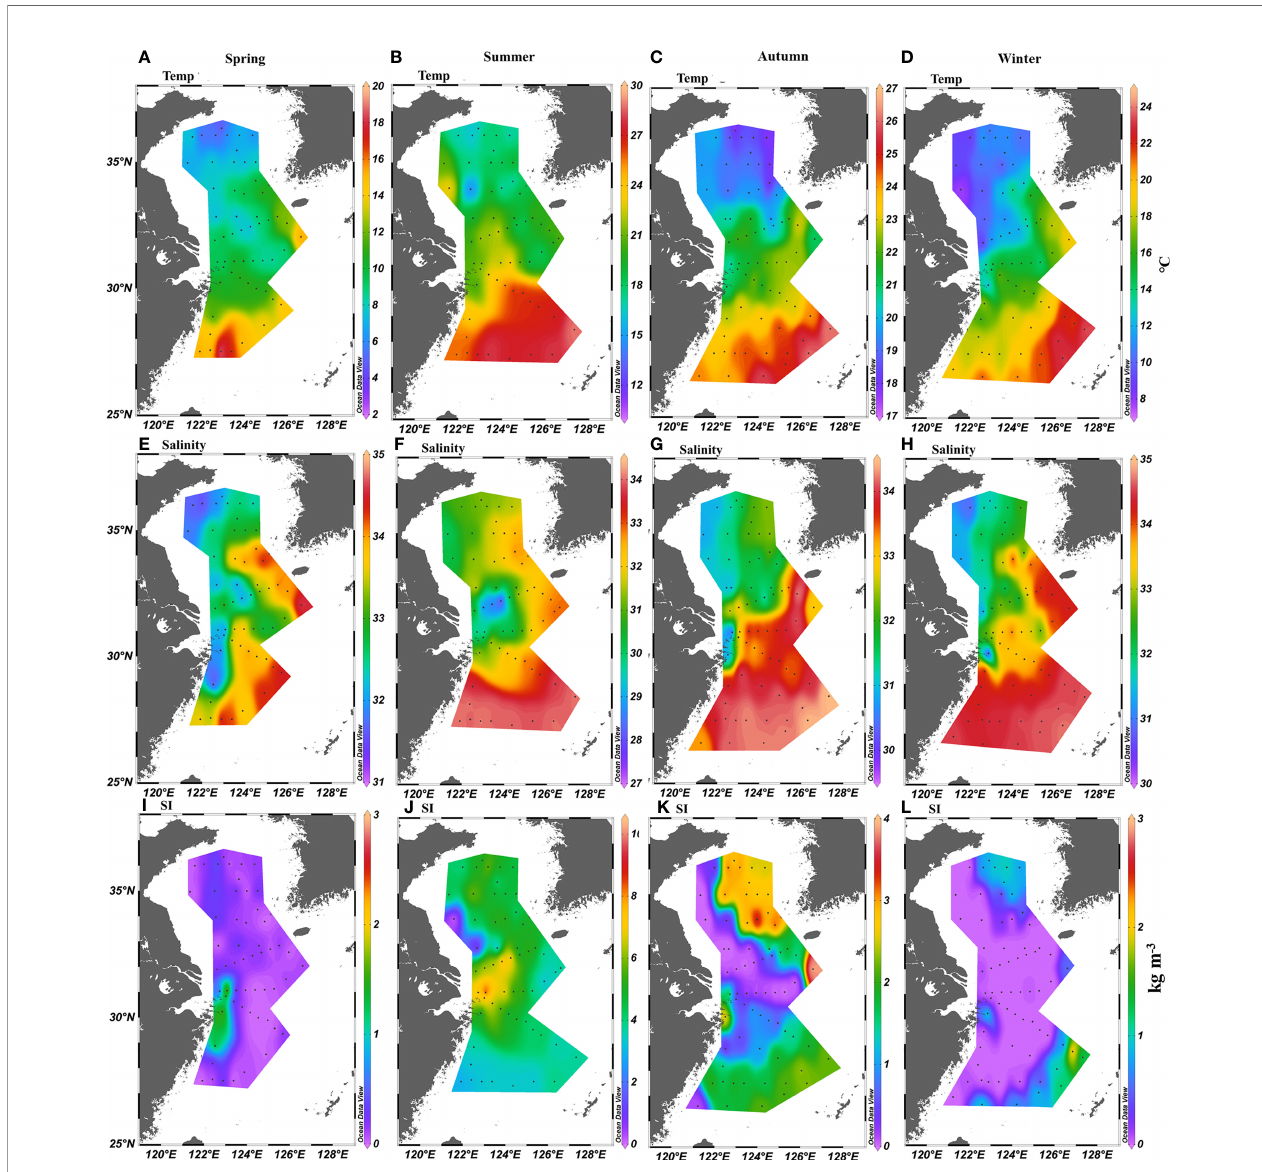
FIGURE 2 | Distribution of depth-average (A – D) temperature (°C) and (E – H) salinity in the upper 30-m water column, and (I – L) strati fi cation index (kg m -3 ) in the East China Sea and southern Yellow